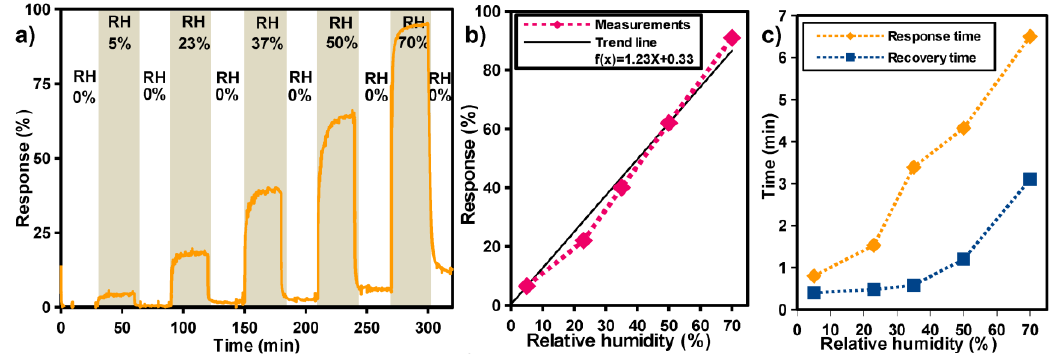
Figure 8. ( a ) response curve of the sensor to gradually increased humidity levels, ranging from 0 up to 72%; ( b ) sensor response as function of the relative humidity; ( c ) response and recovery time of the sensor as function of the relative humidity. [57].